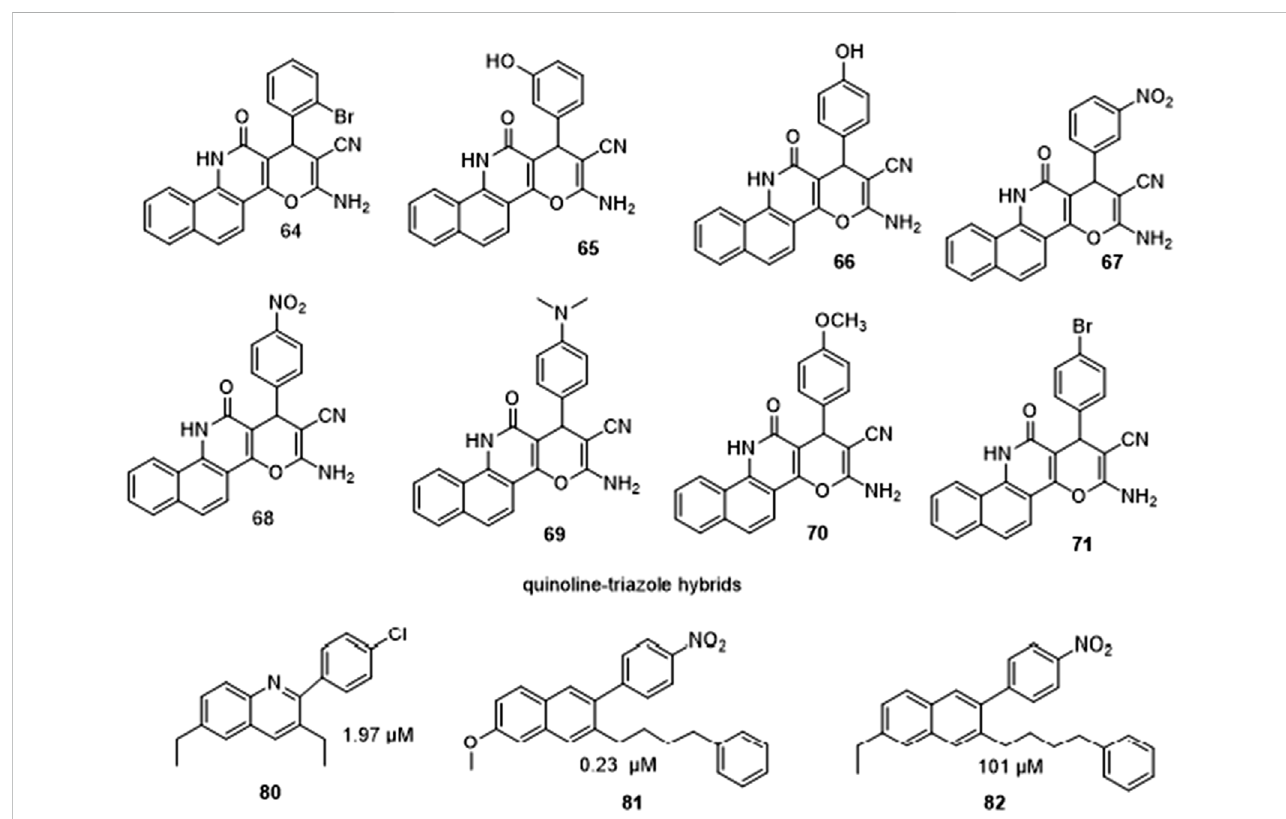
FIGURE 14 SAR studies showing change in potency of quinoline derivatives as substituent